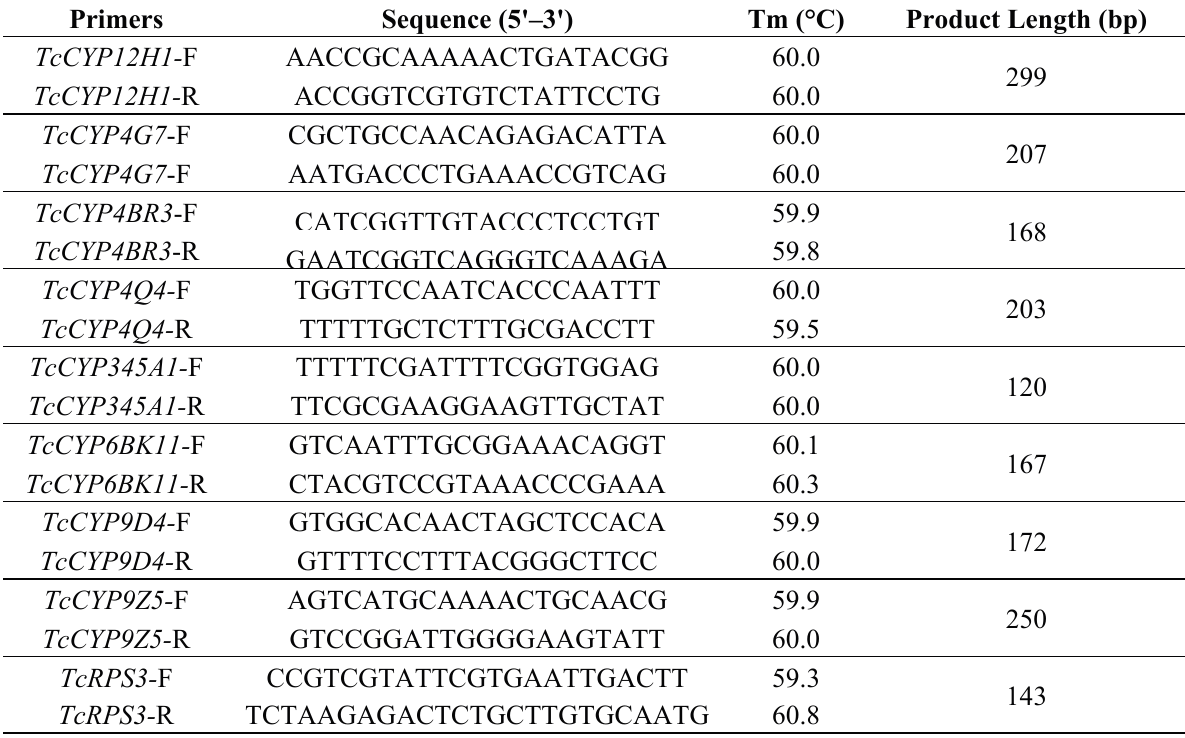
Table 3. Primers used to analyze transcript levels of CYP genes in T. castenuem